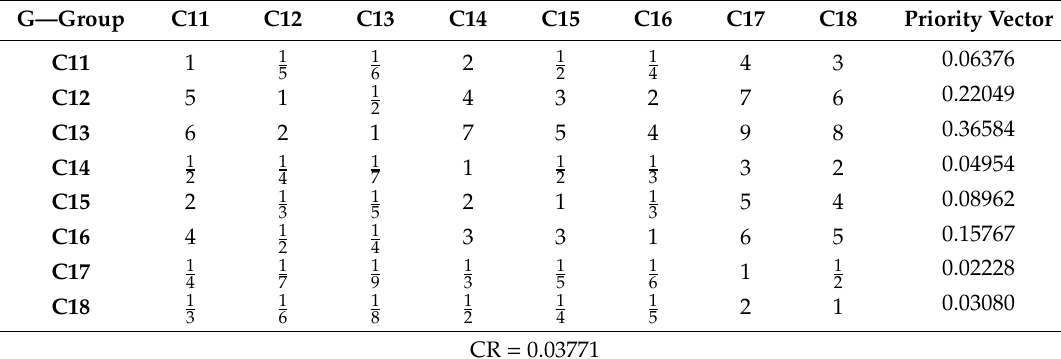
Table 7. Comparison matrix for Geospatial Factors criteria